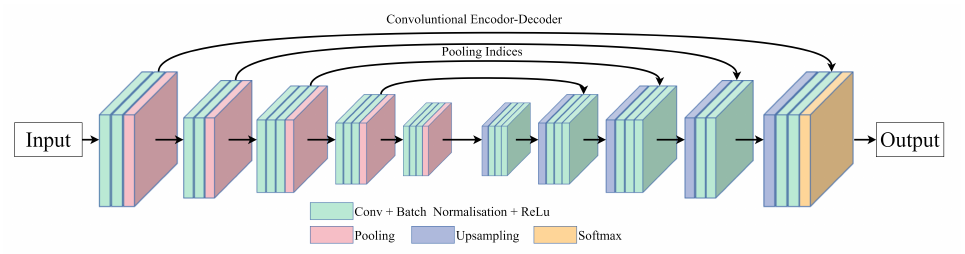
Figure 7. Diagram of SegNet